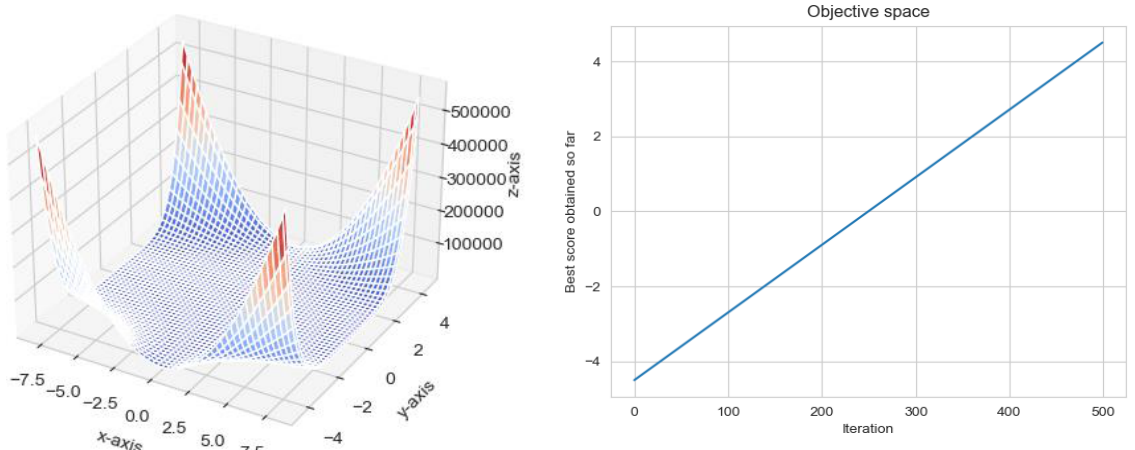
Figure 7. For function-F1 convergence curve has shown.